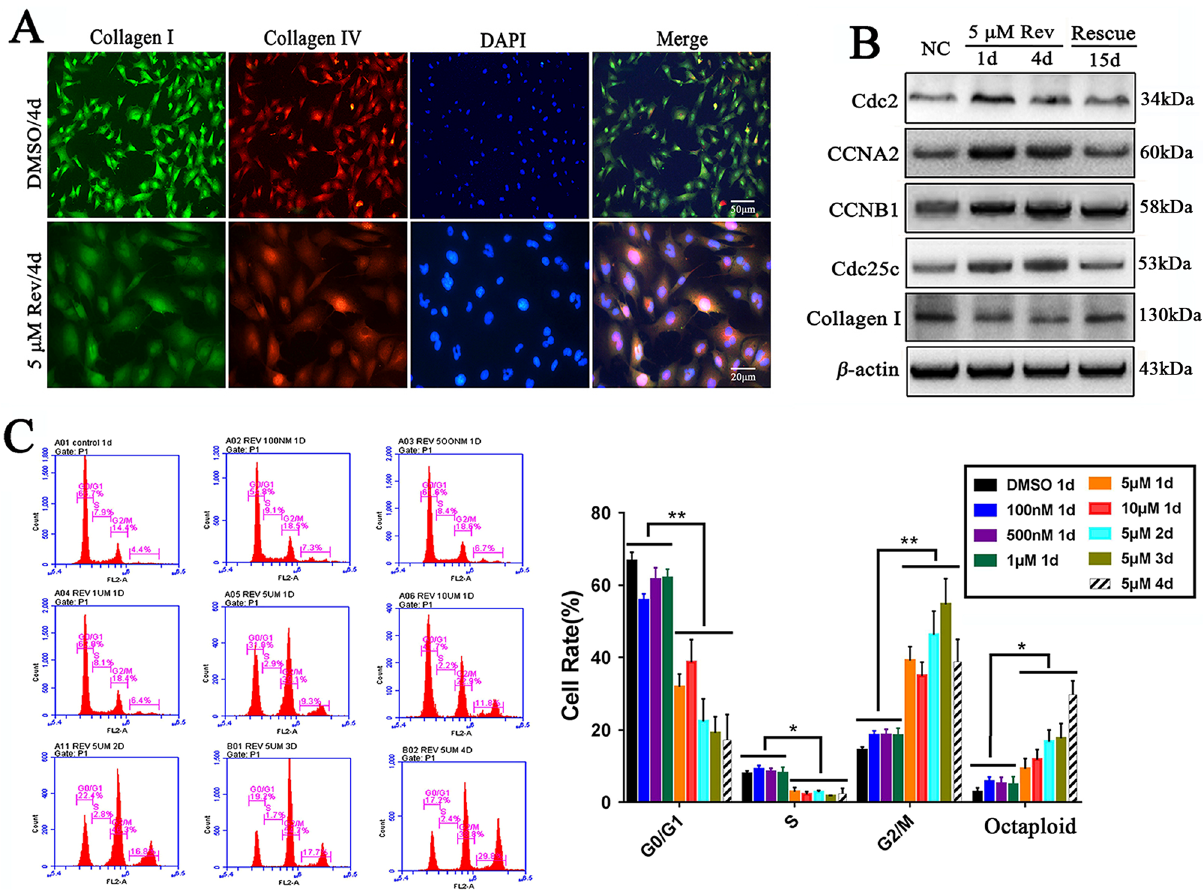
Figure 2. Cell cycle and ECM proteins alteration in reversine treated fibroblasts. ( A ) Reversine reduced the expression of collagen-I and collagen-IV proteins. ( B ) Reversine treatment promoted the expression of G2/M regulatory proteins, including Cdc2, Cyclin A2, Cyclin B1 and Cdc25c. ( C ) Fibroblasts treated with reversine exhibited significantly difference in the percentages of sub-G1, G0/G1, S, and G2/M phase